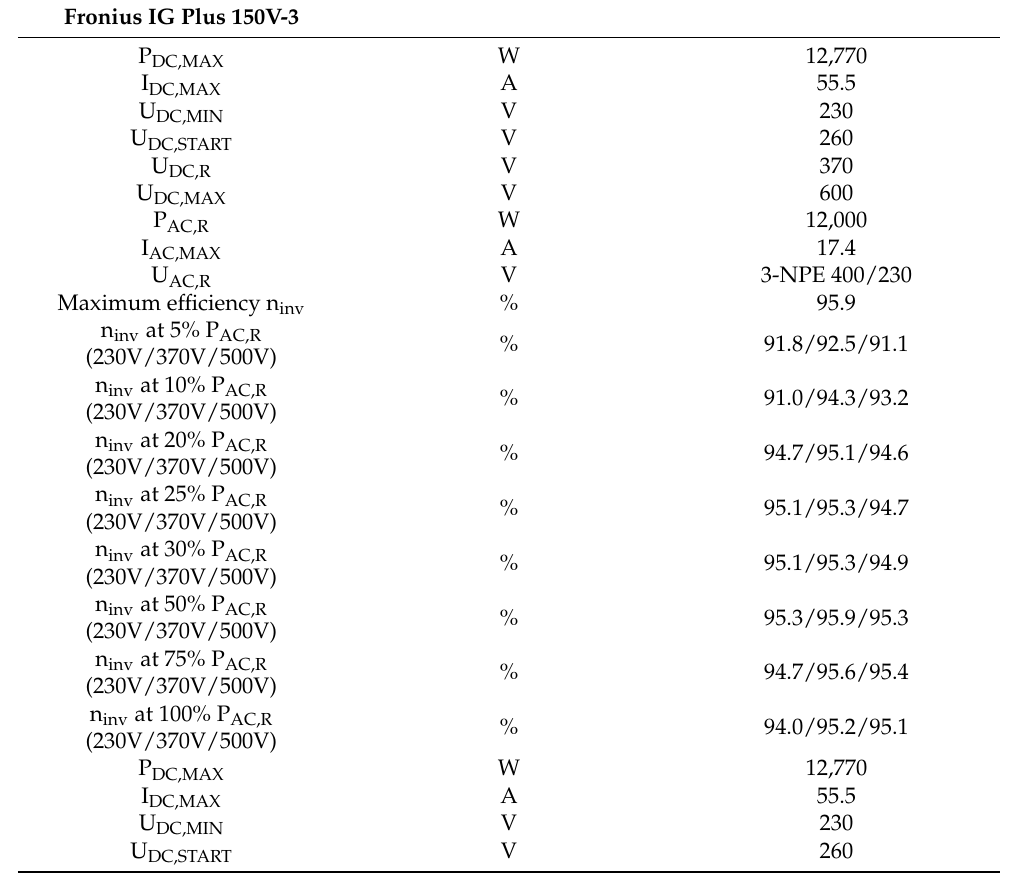
Table A2. Technical characteristics and efficiency ratings of